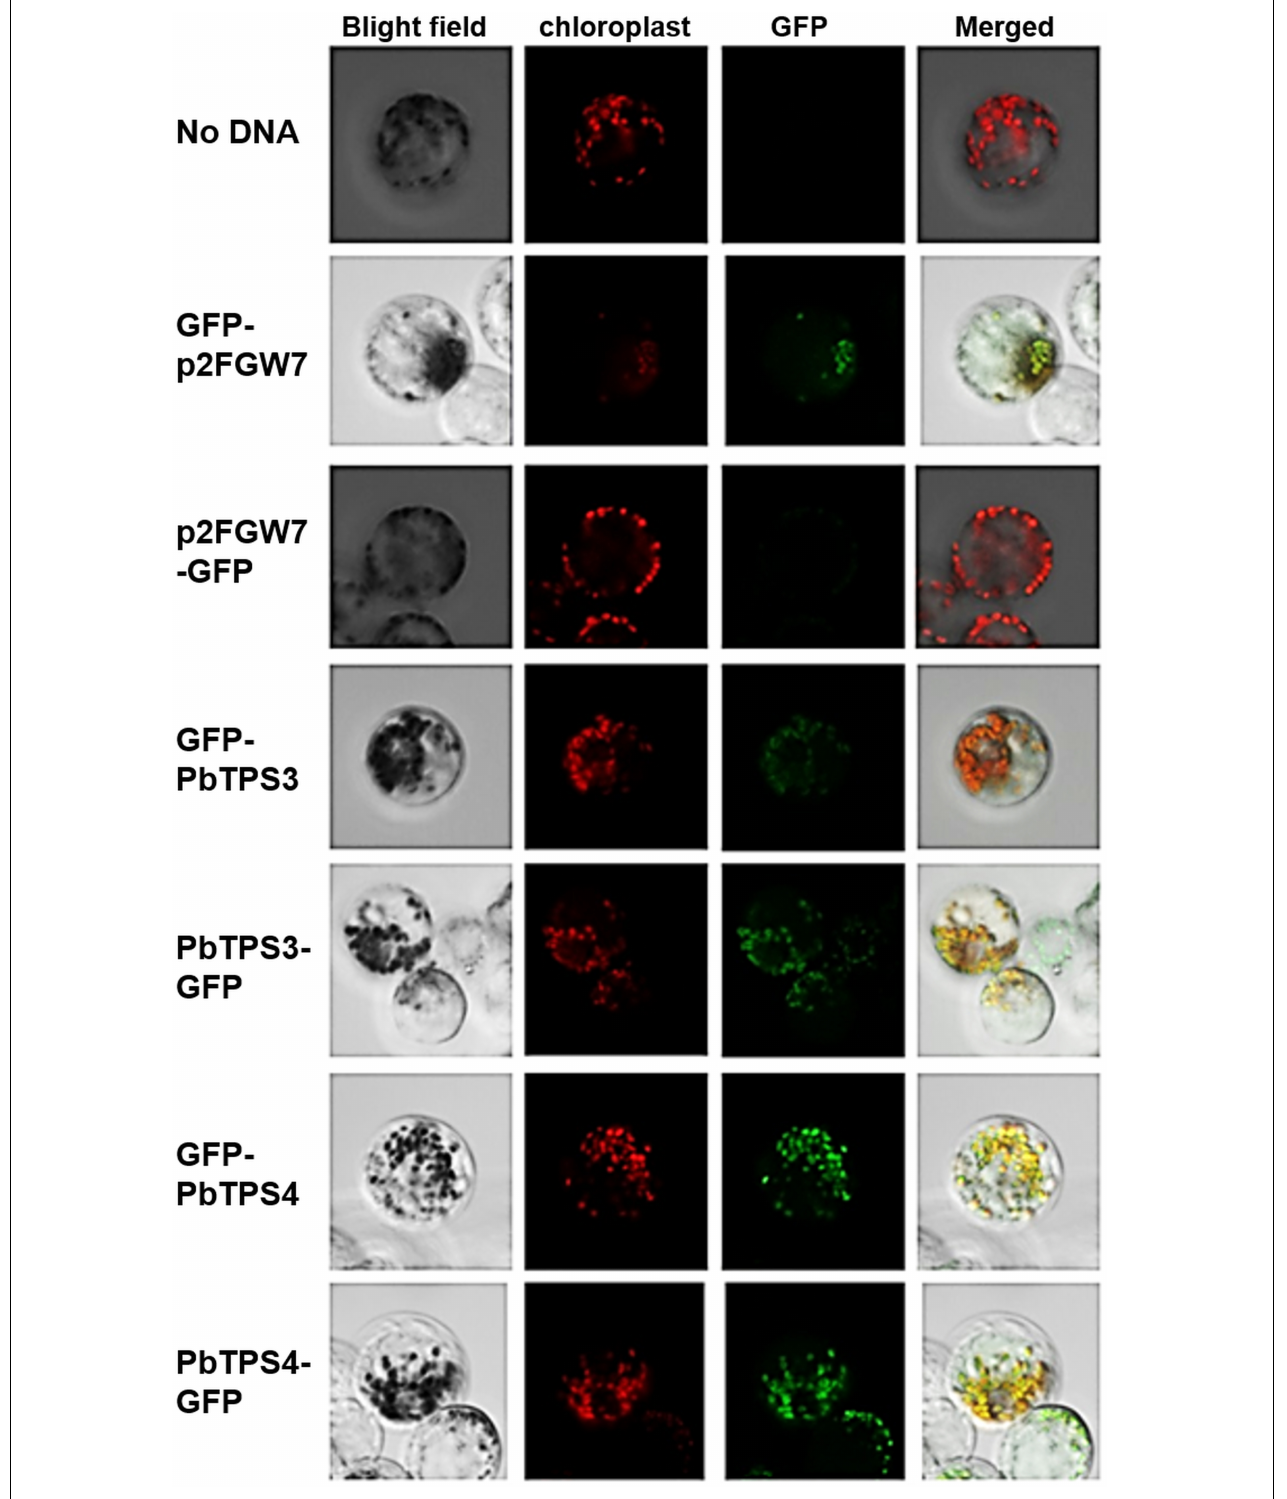
FIGURE 7 | Subcellular localization of PbTPS3 and PbTPS4 . Protoplasts of Phalaenopsis aphrodite tepals were transformed with GFP fusion proteins (GFP-PbTPS3, PbTPS3-GFP, GFP-PbTPS4, and PbTPS4-GFP). Images were taken by confocal laser scanning microscopy. Bright field, the image in bright field; Chloroplast with autofluorescence image false-colored in red; GFP, GFP fluorescence image false-colored in green; Merge, merge of bright field, chloroplast and GFP fluorescence images.